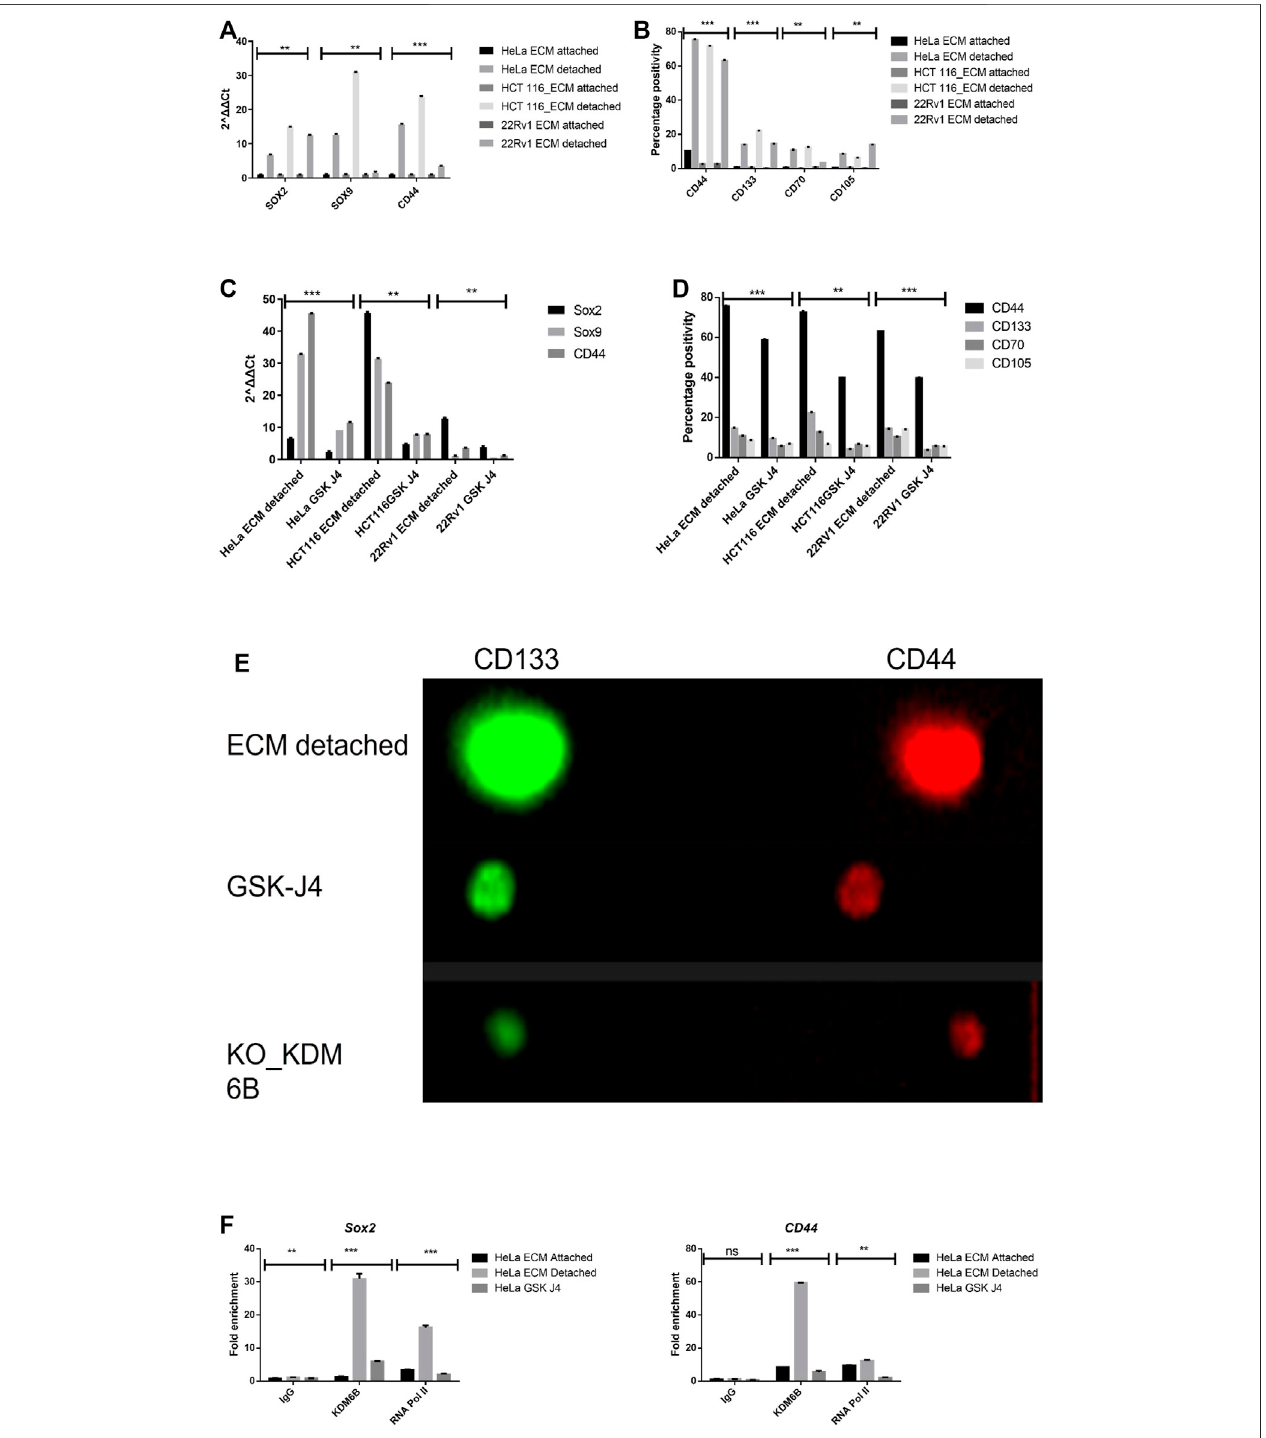
FIGURE 3 | MatrixdetachmentinducestheexpressionofstemnessmarkersthatarerepressedbytheKDM6B-speci fi cinhibitor. (A) mRNAexpressionofvariousstemness- related genes ( SOX2 , SOX9 , and CD44 ) in HeLa, HCT116, and 22Rv1 cell lines during matrix detachment at six days. The values were normalized with the housekeeping gene RPLP0 , and other gene expression values were calculated. (B) Flow cytometry – based expression of various surface markers of stemness in HeLa, HCT116, and 22Rv1 cell lines during matrix detachment for six days. (C) Spheroids were treated with GSK-J4 (5 µM for HeLa and 22Rv1,10 µM for HCT116), a speci fi c inhibitor of KDM6 histone demethylases.Moreover,themRNAexpressionofvariousstemness-relatedgenes( SOX2 , SOX9 ,and CD44 )inHeLa,HCT116,and22R ʋ 1celllinesweremeasuredasexplained